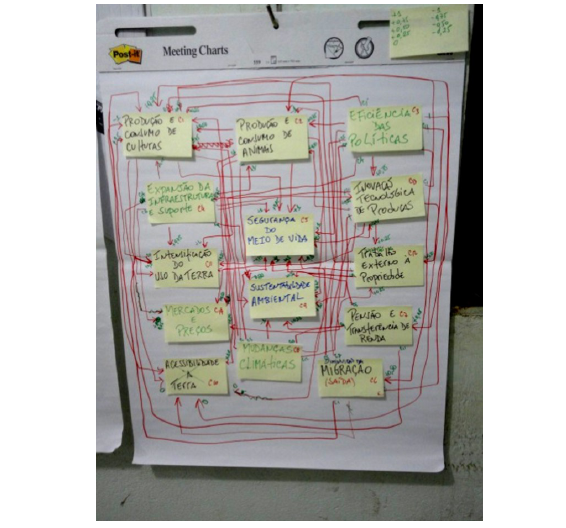
Fig. 3 . Example of a fuzzy cognitive map obtained in the off- farm